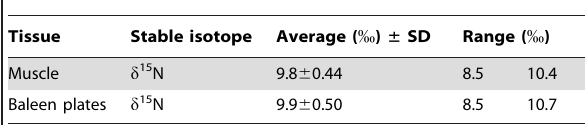
Table 1. Mean 6 standard deviation and range of the nitrogen stable isotope results in muscle and baleen plates (mean of all